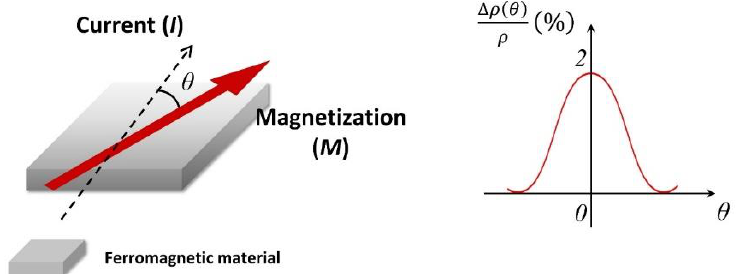
Figure 1. Schematic diagram of anisotropic magnetoresistance (AMR).